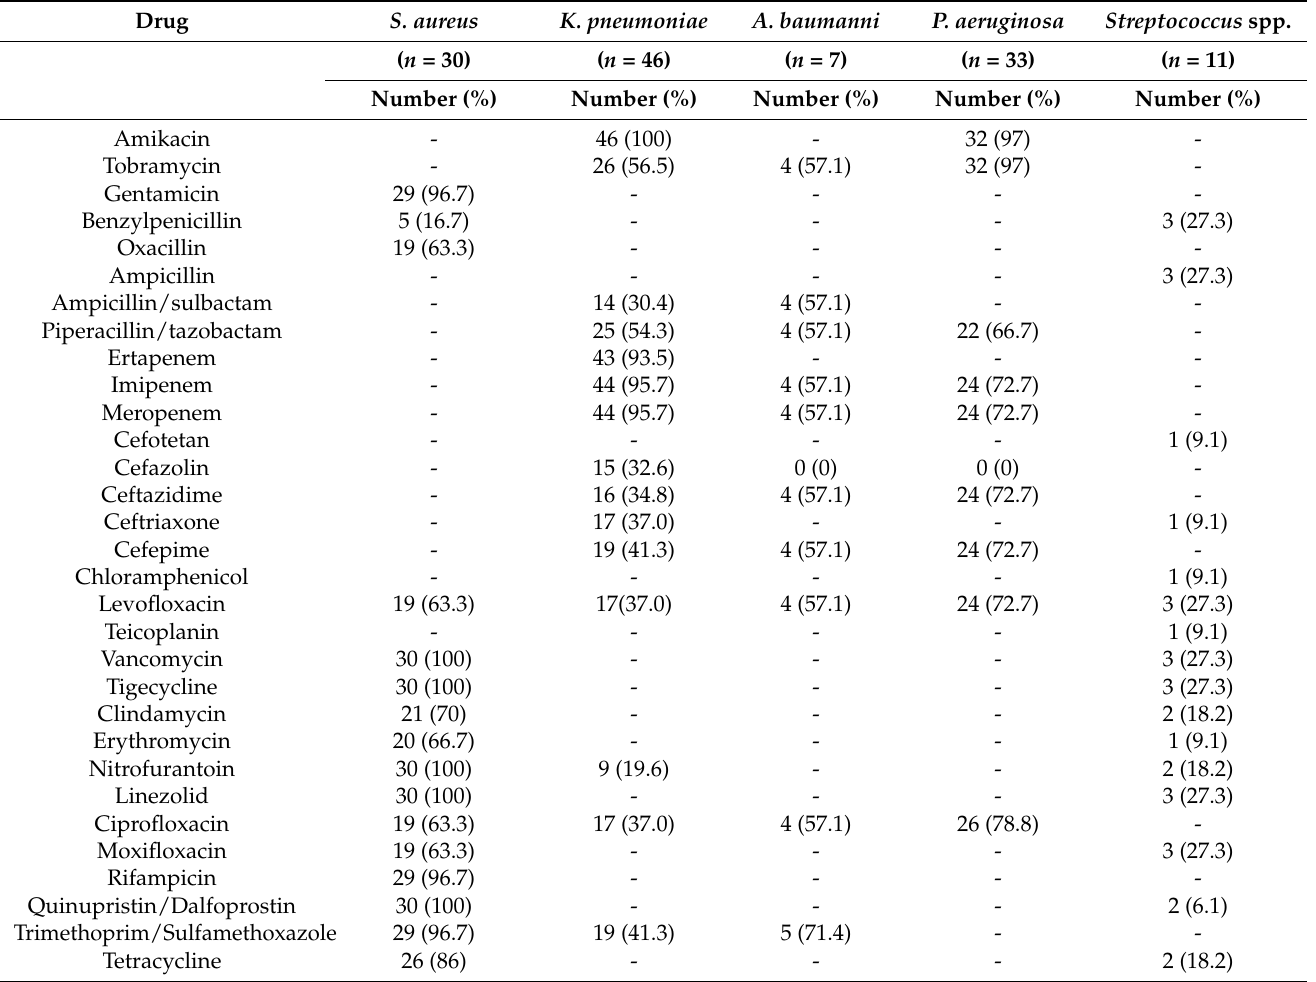
Table 4. Susceptible profiles of isolates to β -lactam and non- β -lactam antibiotics.